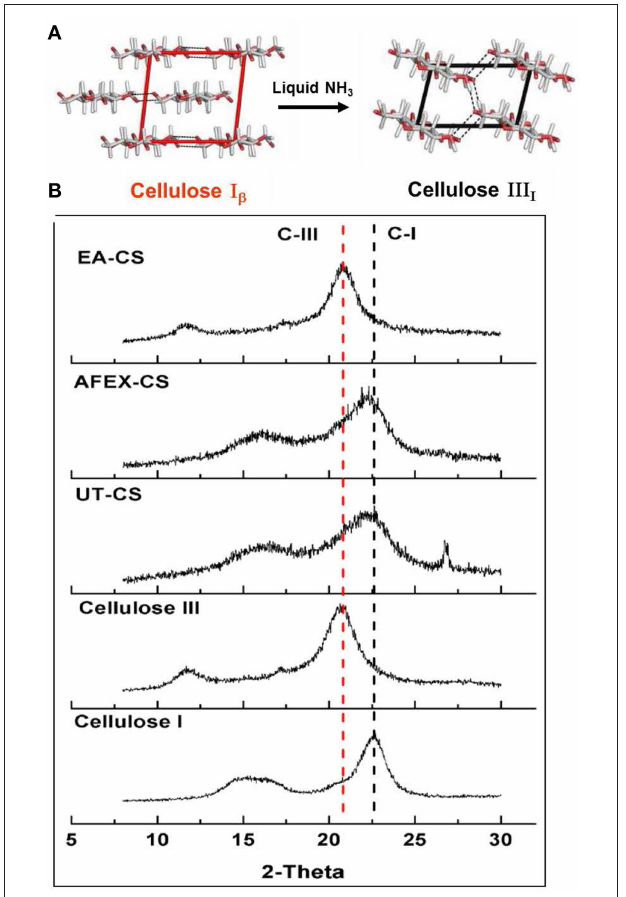
FIGURE 2 | Structure change of cellulose after ammonia treatment. Here, (A) represent glucose gain packing in two different allomorphs of cellulose I (CI) and cellulose III (CIII) and (B) powder X-ray diffraction of CI, CIII, untreated corn stover (UT-CS), AFEX treated corn stover (AFEX-CS) and Extractive ammonia treated corn stover (EA-CS). Crystallinity of cellulose changes from CI to CIII in the case of EA-CS, while, AFEX-CS still have CI similar to UT-CS.